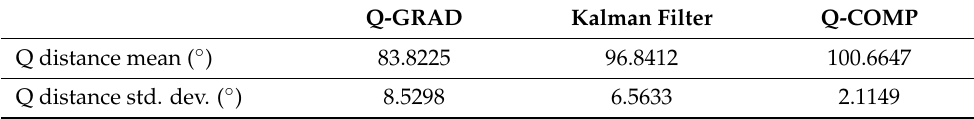
Table 5. RMS values of quaternion distance using various onboard orientation filters.